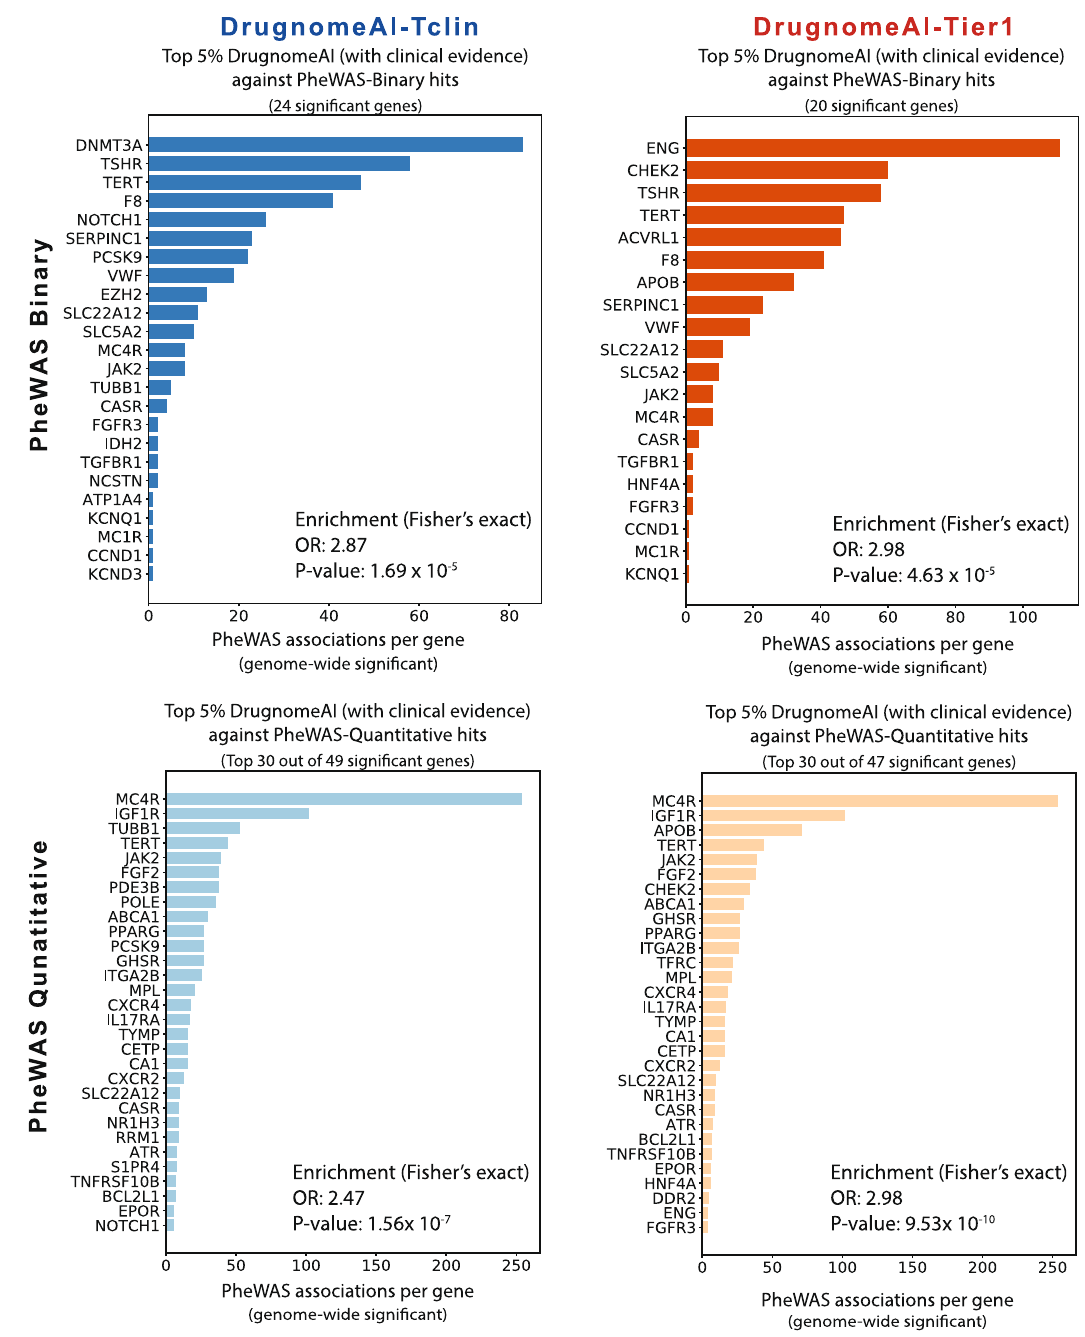
Fig. 5 Enrichment of top 5% genes ( n = 992) ranked by DrugnomeAI-Tclin and DrugnomeAI-Tier1 and supported by clinical evidence among the top UKB PheWAS hits for binary and quantitative traits. Genome-wide signi fi cant hits ( p < 5 × 10 − 8 ) have been considered from the PheWAS analysis on 450 K samples from UKB. While the common top hits from DrugnomeAI and PheWAS are sorted by the number of signi fi cant hits in PheWAS for visualisation purposes, it is expected that many of the associated phenotypes may be highly